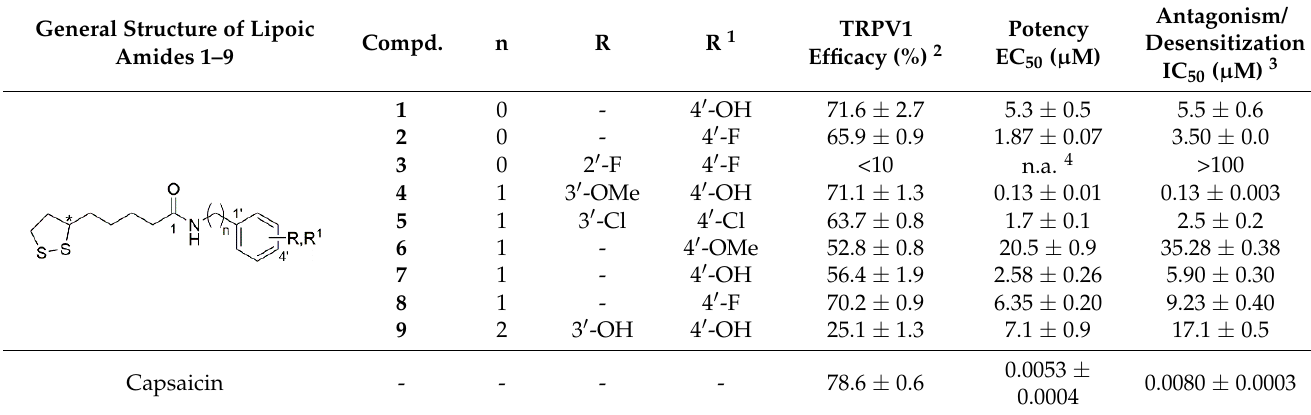
Table 1. Chemical structure and results of TRPV1 functional assay of the lipoic amides 1–9 1 .